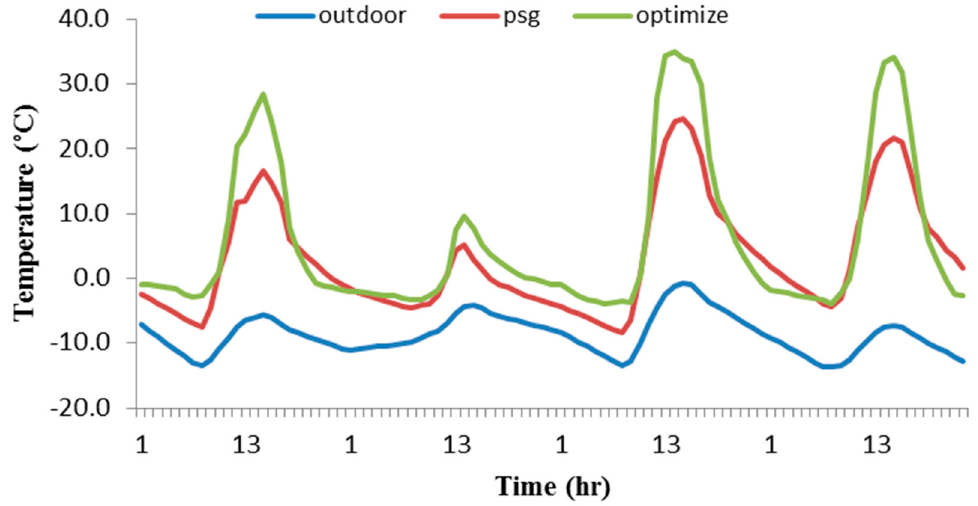
Figure 9. The average indoor air temperatures in the optimized and PSG models.